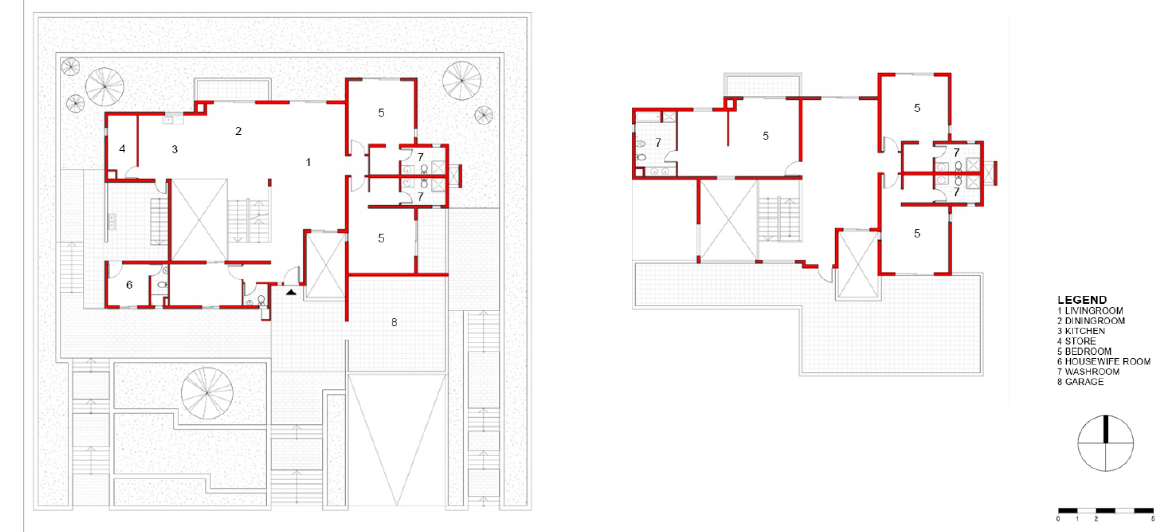
Figure 49. The Umudugudu Kigali Vision: Ground and first floor, 5-bedrooms Villa. Drawing by Manlio Michieletto.